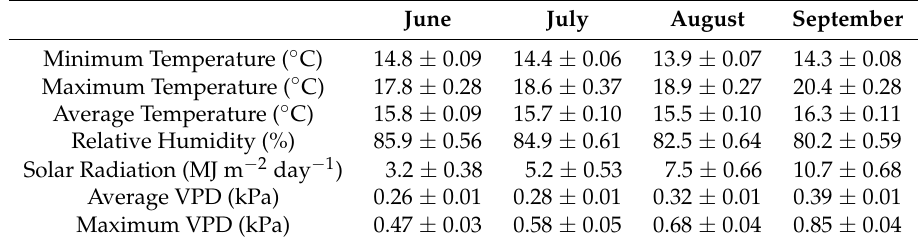
Table 2. Environmental conditions during the experimental period 2018 (E2). Average daily values ± standard error. VPD—Vapor pressure